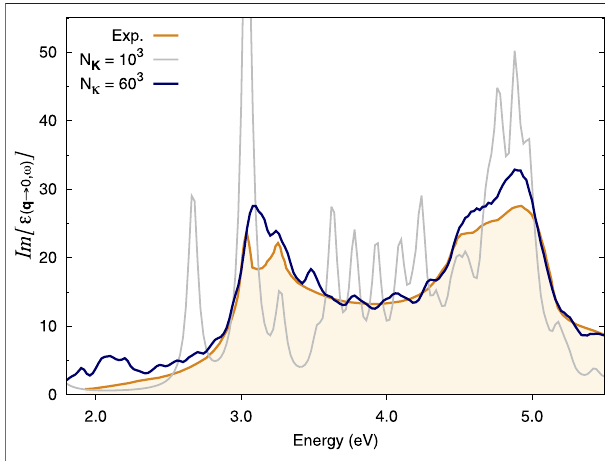
FIGURE 1 | Optical absorption spectra of bulk Si. BSE spectra calculated using the double-grid approach described in this work are assessedagainsttheexperimentalspectrumat10 KfromJellisonandModine (1983). Spectra are calculated on an 8 × 8 × 8 coarse k -grid and a denser fi ne k -grid, indicated by N κ . N K (cid:2) 8 3 corresponds to a standard calculation onan 8 × 8 × 8 k -grid while N κ (cid:2) 60 3 corresponds toadouble-grid calculationwitha60 × 60 × 60 fi negrid.Weconsiderall e − h pairsfromthetop four valence bands to the four bottom conduction bands. All k -grids are Gamma-centred.